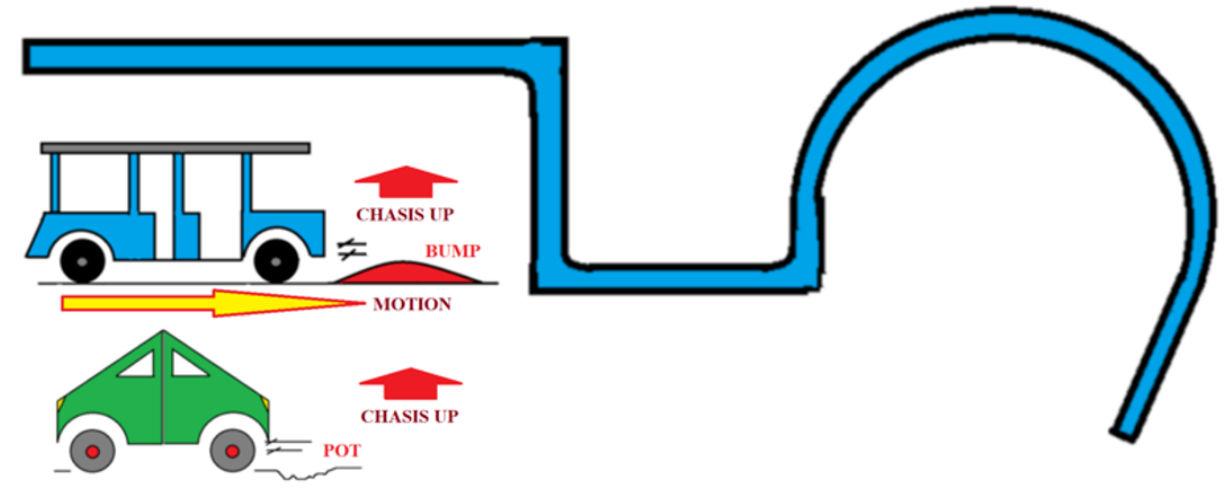
Figure 12. Path following idea to automate the vehicle